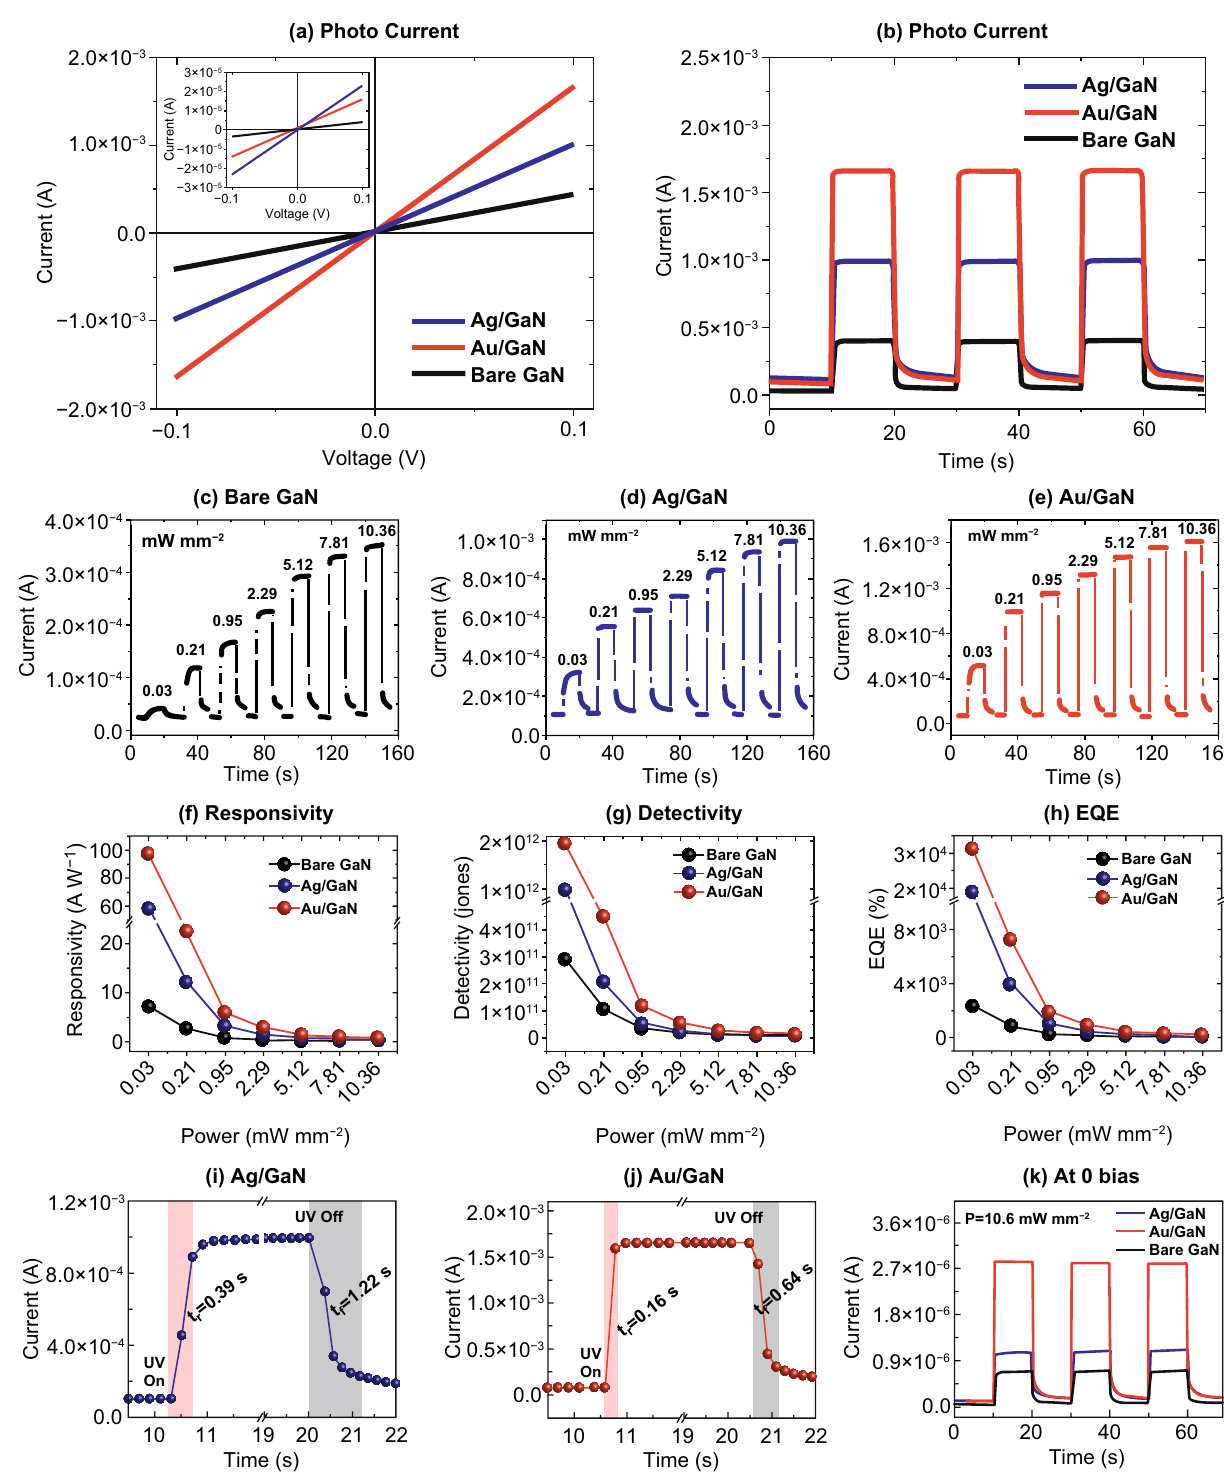
Fig. 3 Photoresponse characteristics of the bare GaN, Ag and Au photodetectors. a Current–voltage ( I–V ) characteristics of each device under 385 nm UV illumination at 10.36 mW mm −2 . Inset shows the corresponding dark current. b Current–time ( I–t ) characteristic at 0.1 V by switch‑ ing on/off. c – e Photon power‑dependent photoresponse of the devices. f – h Summary of the photoresponsivity ( R ), detectivity ( D ) and external quantum efficiency ( EQE ) as a function of photon power. i – j Rise ( t r ) and fall ( t f ) time of the Ag and Au detectors upon switching on/off. k Cur‑ rent–time ( I–t ) characteristic at 0 bias under 10.36 mW mm −2 UV